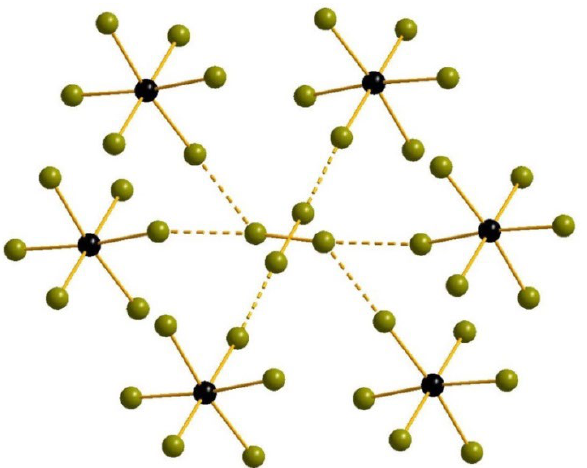
Figure 2. Br···Br interactions in the structure of 2. Only one position of disordered bromide ligands is shown.